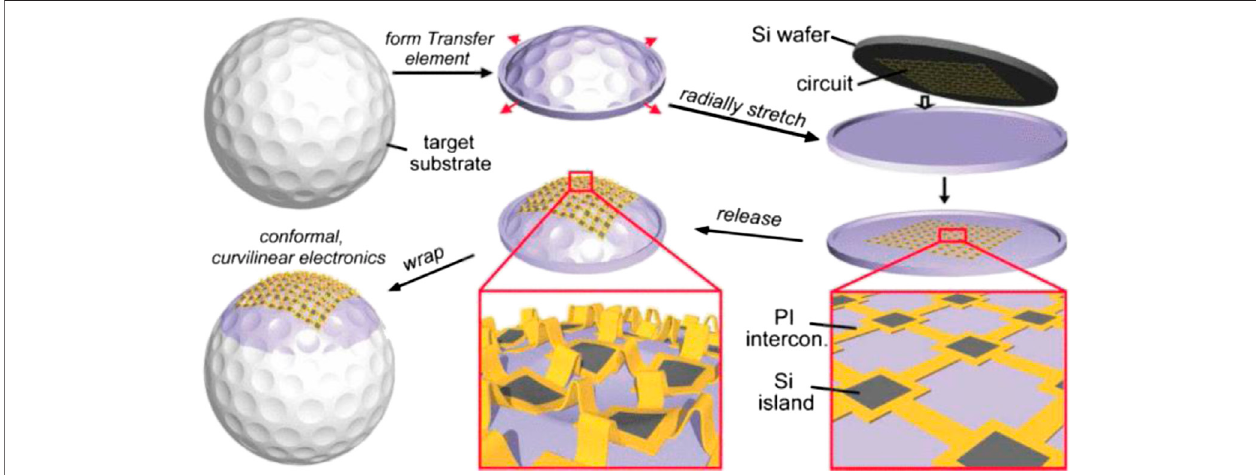
FIGURE 6 | Schematic illustration of the steps for using silicon membrane circuits in mesh layouts (i.e., arrays of islands interconnected by narrow strips) and elastomeric transfer elements to wrap electronics onto substrates with complex curvilinear shapes, such as the dimpled surface of the golf ball shown here (Ko et al., 2009). Reproduced with